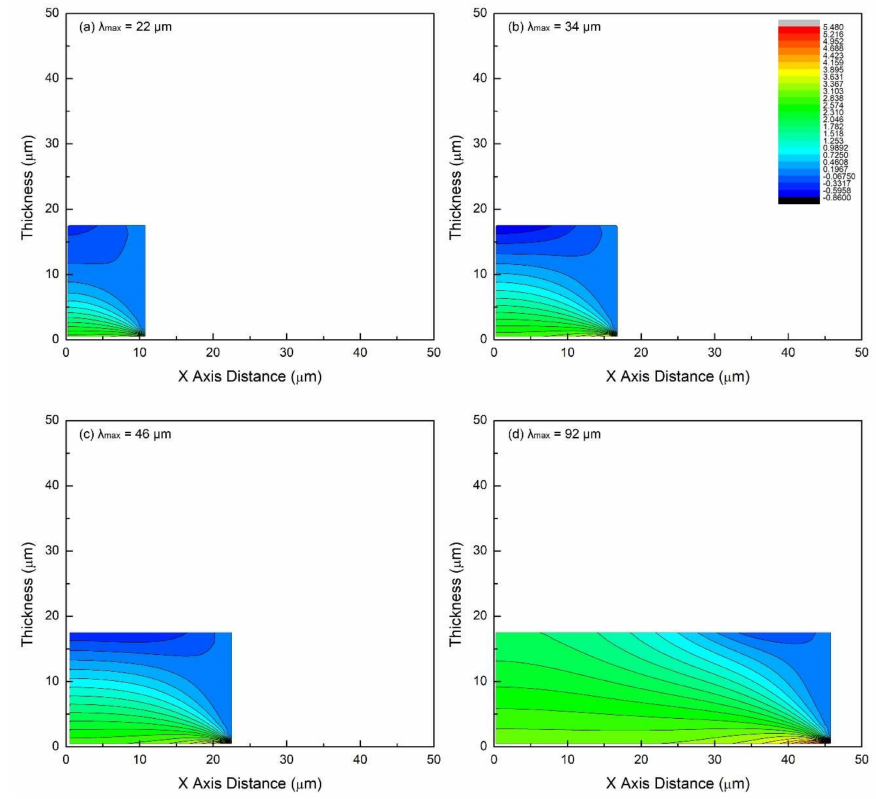
Figure 5. The in-plane stress distribution (2D-contour plot) in films of different crack spacing for the case of the film/substrate system being tested in tension: ( a ) λ max = 22 µ m, ( b ) λ max = 34 µ m, ( c ) λ max = 45 µ m, ( d ) λ max = 92 µ m. Common features: E SS = 200 GPa, E PDC = 50 GPa, δ = 18 µ m, ε f =